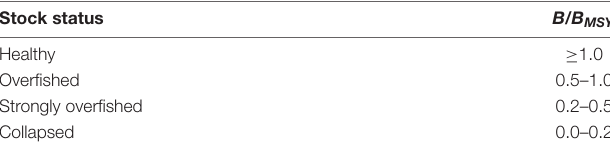
TABLE 4 | Stock status categories corresponding to the range of B / B MSY of stocks under assessment (Palomares et al.,